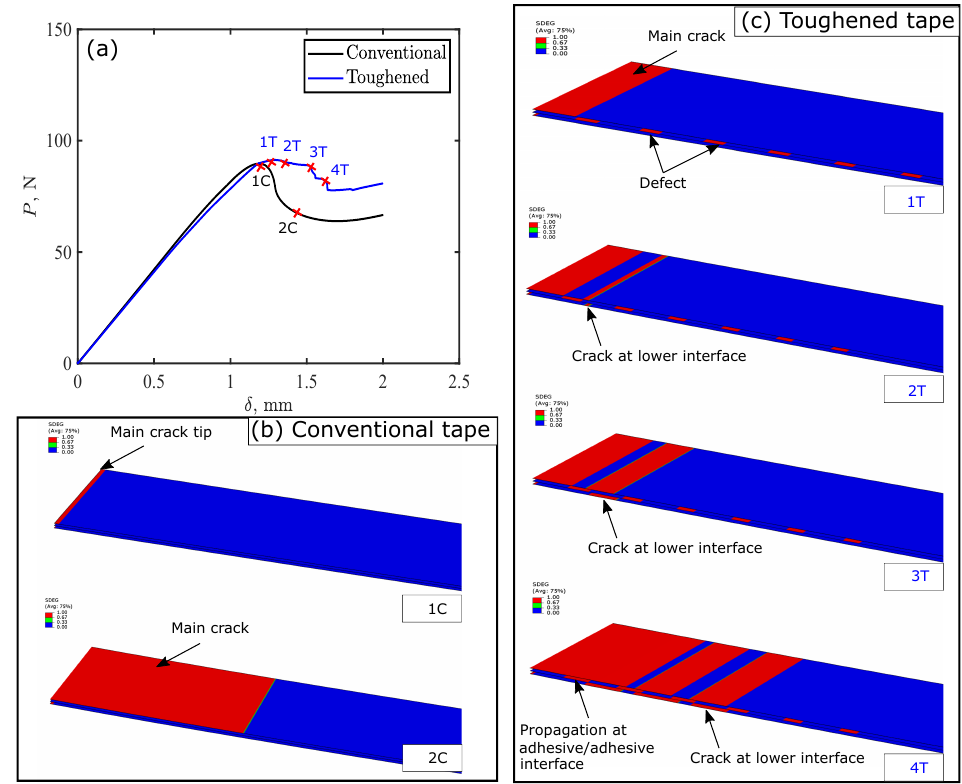
Figure 11. Toughening mechanisms in thermoplastic adhesive tapes with 2 mm defect length and 5 mm gap between defects: ( a ) load-displacement curves for end notch flexural (ENF) simulation; and crack propagation in ( b ) conventional, and ( c ) toughened